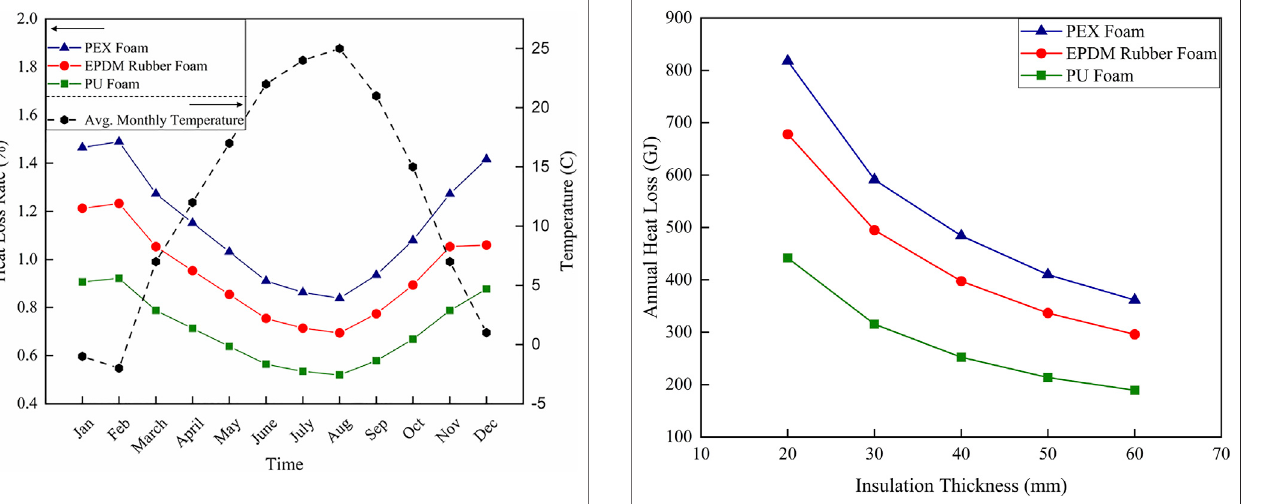
FIGURE 6 | Monthly heat loss rate for different insulation materials and average monthly